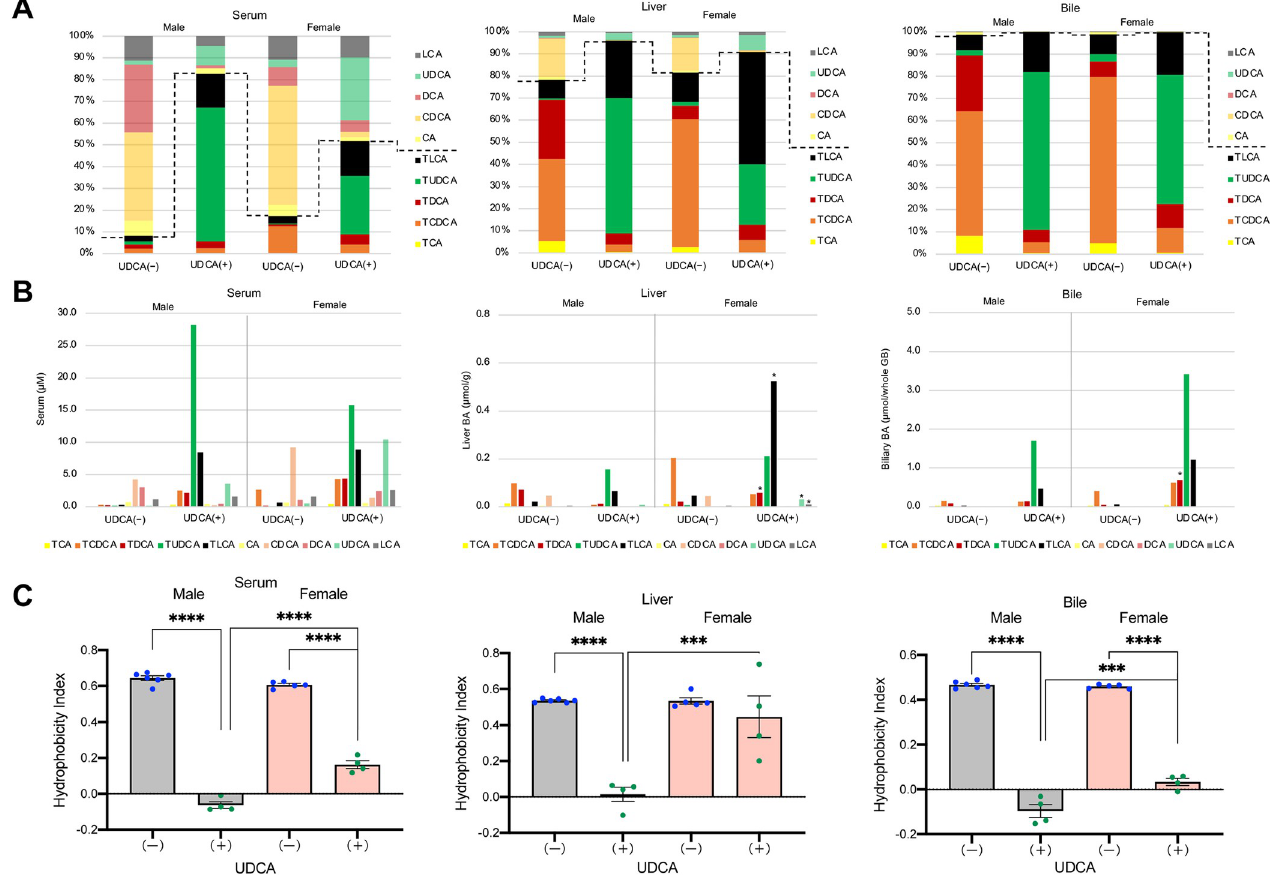
Fig 4. Comparison of BA compositions, concentrations, and hydrophobicity indices among serum, liver, and bile. DKO mice at 20 weeks of age, with (+) or without (-) UDCA treatment, were compared. (A) BA compositions in serum, liver, and bile. The broken lines indicate the boundary between conjugated and unconjugated BAs. (B) BA concentrations in serum, liver, and bile. � P < 0.05 was considered statistically significantly different from UDCA treated male mice by the Tukey-Kramer test. (C) Hydrophobicity indices of total BAs in serum, liver, and bile. Each column and error bar represents the mean and SEM. �� P < 0.01, ��� P < 0.001, and ���� P < 0.0001 were considered statistically significantly different by the Tukey-Kramer